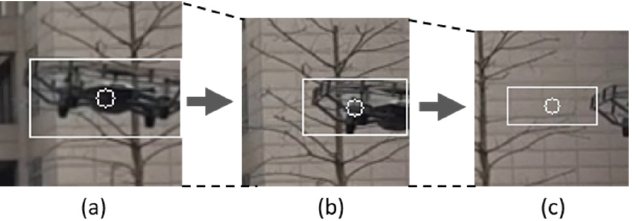
Figure 5. Shrinkage of SR in the CSR tracker. ( a – c ) are the SR images in the sequential frames. The white box is the bounding box estimated by the FCNN.